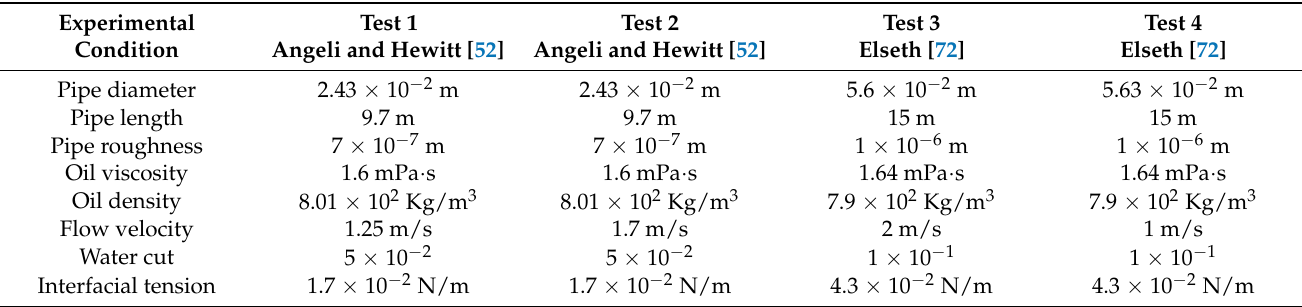
Table 1. The fluid properties and the geometrical conditions in the